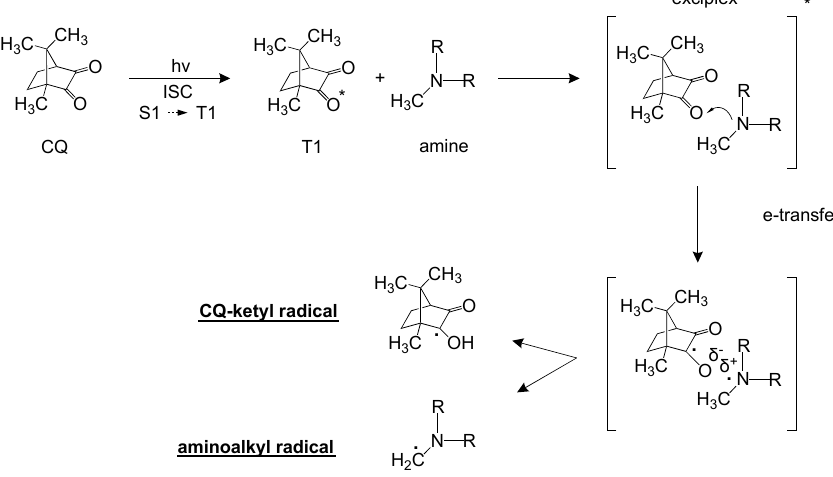
Figure 1. Key steps of free-radical photogeneration pathway of a camphorquinone (CQ)/amine system.